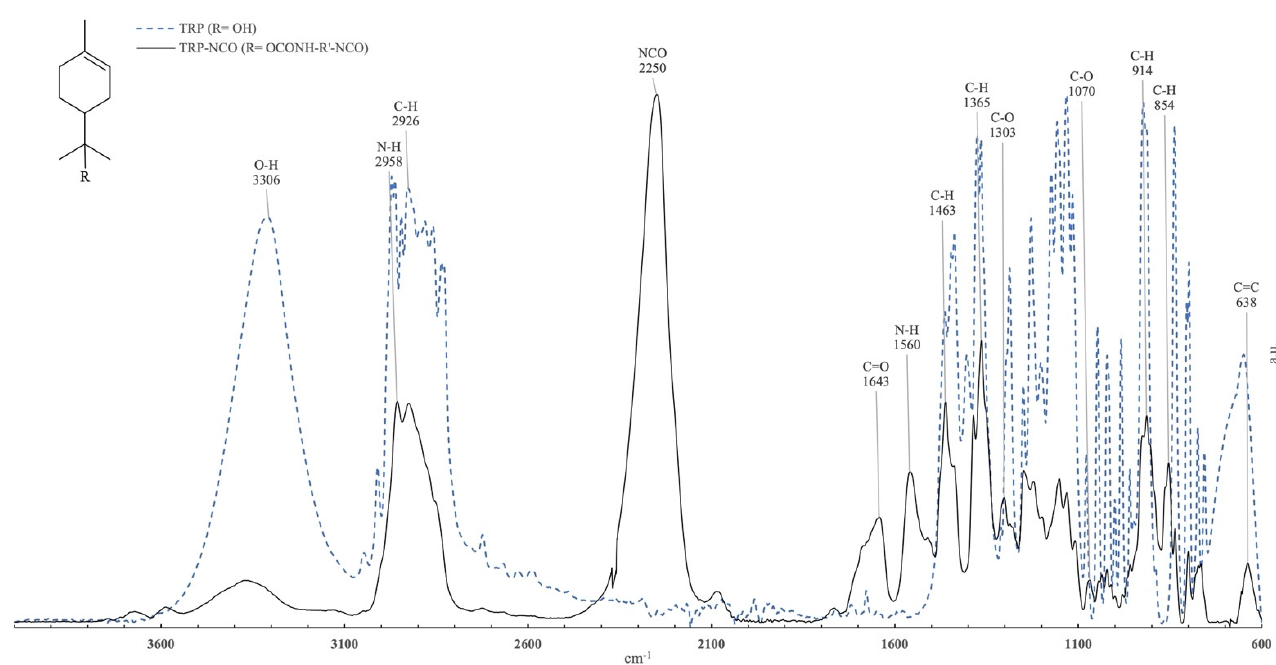
Table 1. Antibacterial activity (R) values obtained for each bacterium after contact with Chloroxy- lenol (CLX), Terpineol (TRP), or CLX+TRP samples, before and after scrub resistance test.